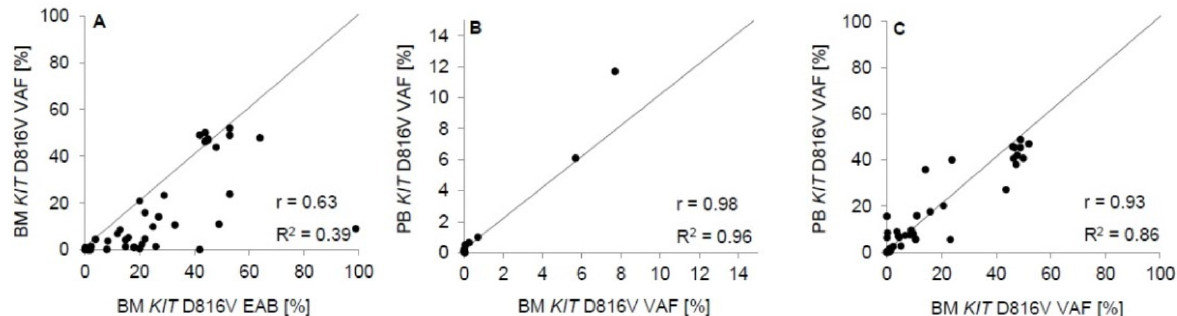
Figure A1. Comparison of VAF and/or EAB in PB and/or BM. ( A ) The comparison of VAF vs. EAB in BM form AdvSM patients ( n = 40) revealed a correlation of r = 0.63 ( R 2 = 0.39). The comparison between the VAF in PB and BM revealed a correlation of r = 0.98 ( R 2 = 0.96) in ISM ( n = 8) ( B ) and r = 0.93 ( R 2 = 0.86) in AdvSM ( n = 37) ( C ); VAF, variant allele fraction; EAB, expressed allele burden; PB, peripheral blood; BM, bone marrow.